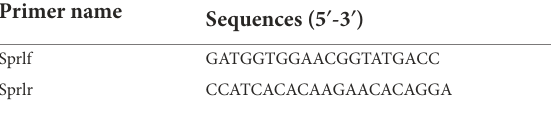
TABLE 1 Primers and sequences used for